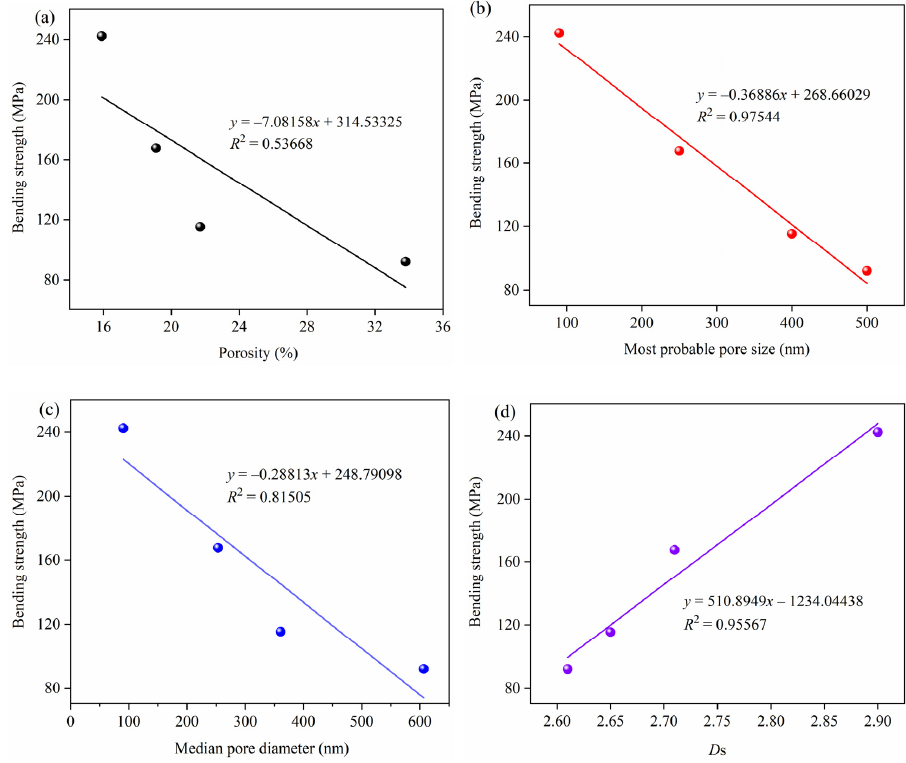
Figure 12. Relationship between bending strength and ( a ) porosity, ( b ) most probable pore size, ( c ) median pore diameter of the porous alumina, and ( d ) D s .